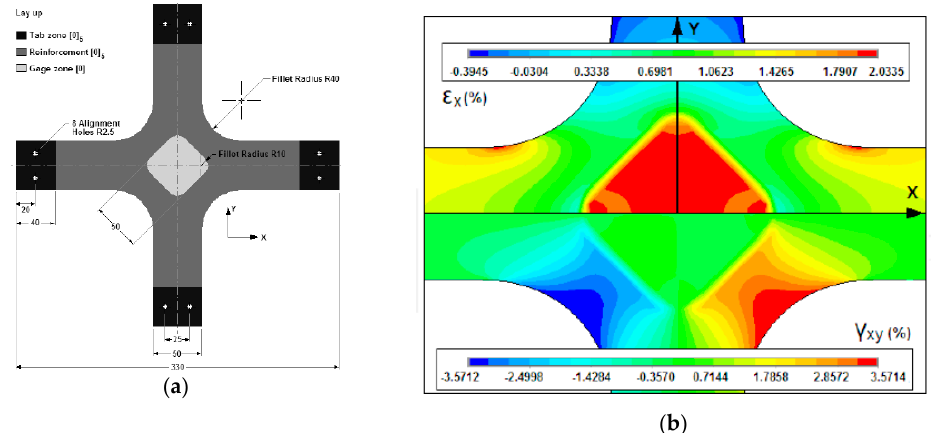
Figure 11. Rhomboidal recessed area specimen: ( a ) overall geometry; ( b ) FEA with strain field at the centre [61].